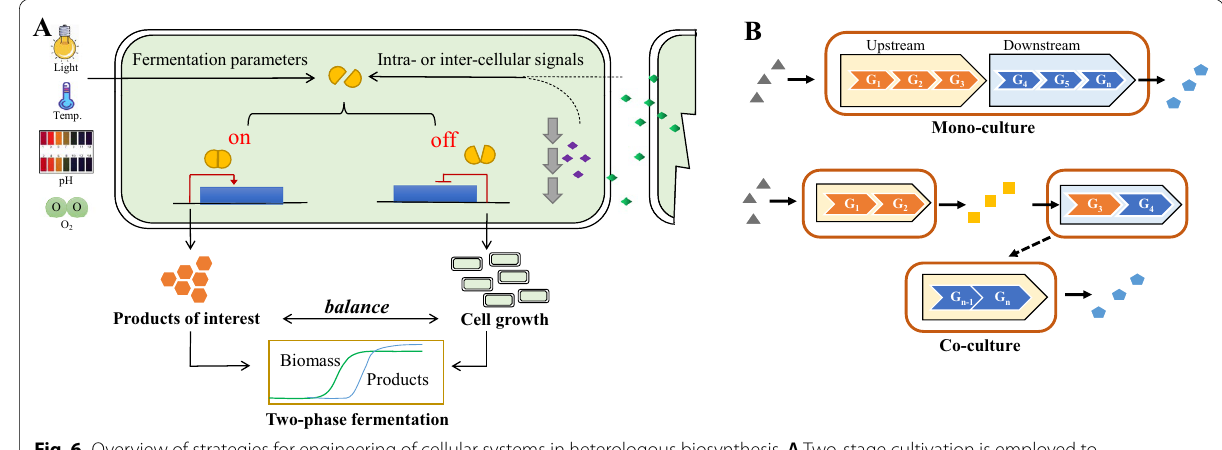
Fig. 6 Overview of strategies for engineering of cellular systems in heterologous biosynthesis. A Two-stage cultivation is employed to maintain normal cell growth while maximizing pigment production, in which environmental signals (like temperature, light, pH and oxygen) and intra-/inter-cellular signals (like QS system) are used as inducers to trigger the switch-on and switch-off of gene expression. B Co-culture engineering provides an alternative approach for efficient pathway engineering via dividing the complex long pathways into several pathway sections in different